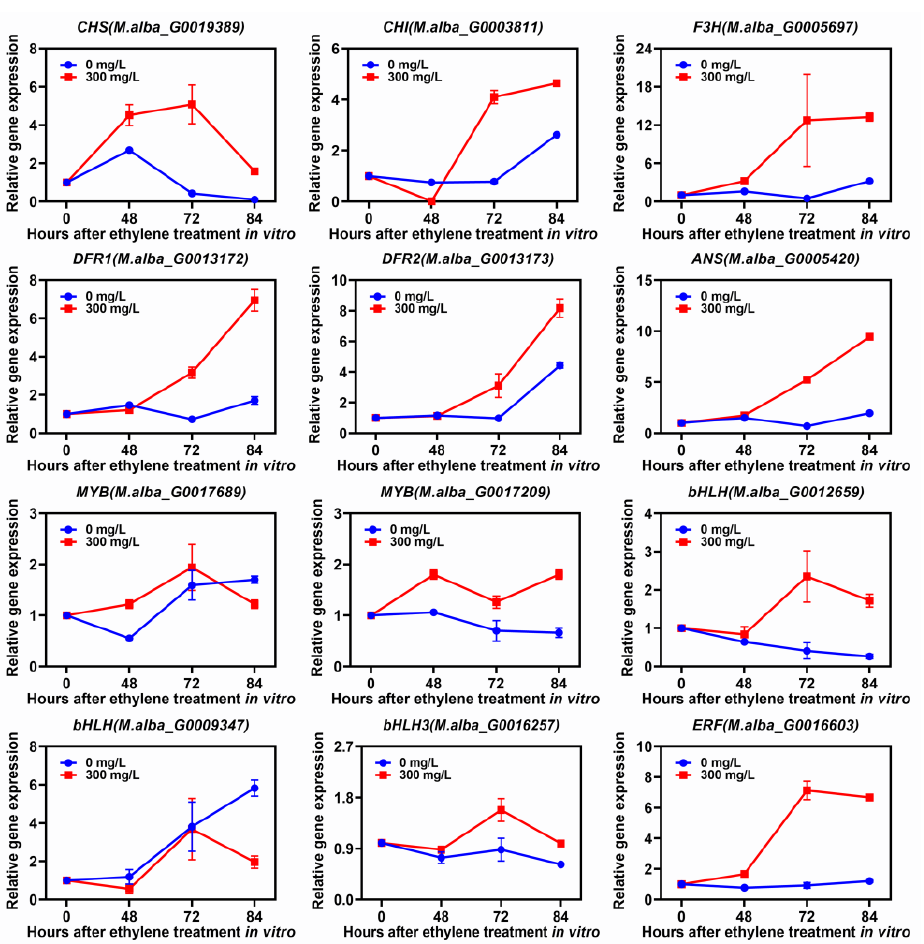
Figure 8. Relative expressions of different genes under in vitro treatment with 300 mg/L ethylene for a different time. Data represent the mean (n = 3) ± SE.